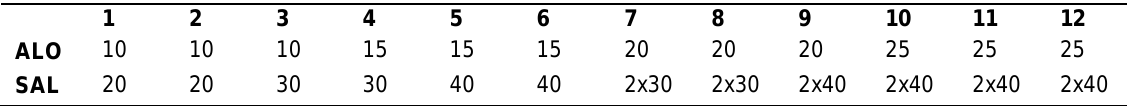
Tabela 1. Duração dos exercícios de alongamento (ALO) e volume de saltos (SAL) ao longo das 12 semanas de